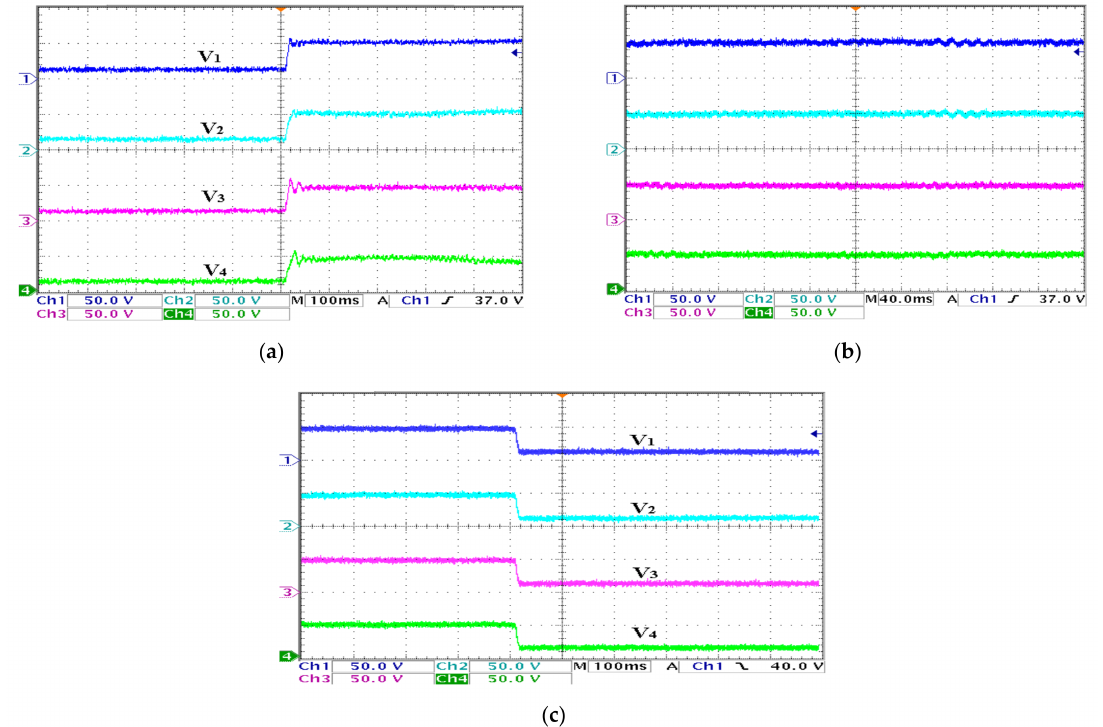
Figure 15. Experimental results of the capacitor voltages (V 1 , V 2 , V 3 and V 4 ) without online tuning for a step response with V in changes between 60 V and 200 V. ( a ) Step-up response, ( b ) steady-state condition, ( c ) step-down